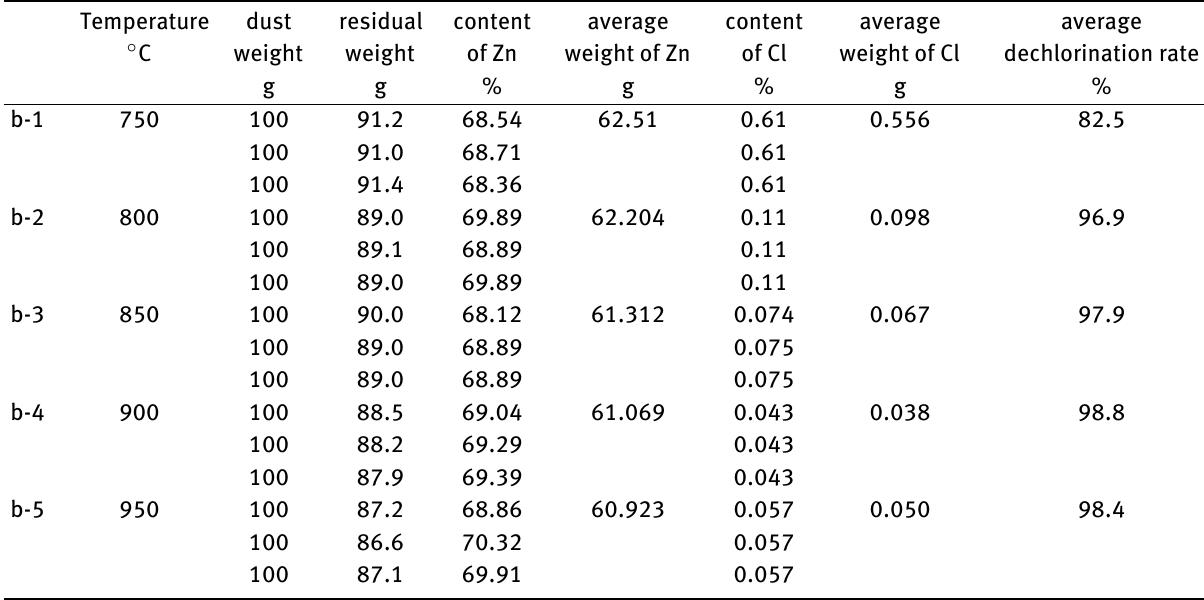
Table 6: Results from experiments (b) involving at different roasting temperatures